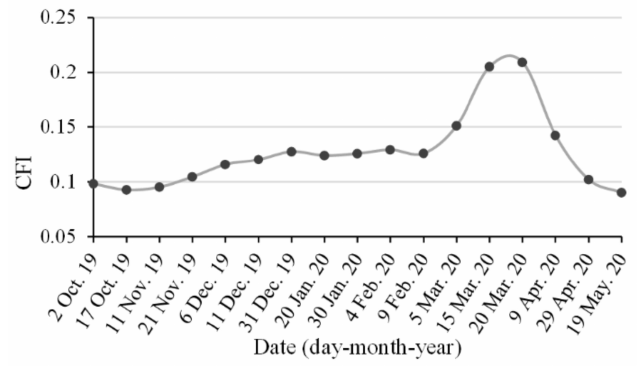
Figure 11. Time series of canola flower index curve of a canola field during its entire growth